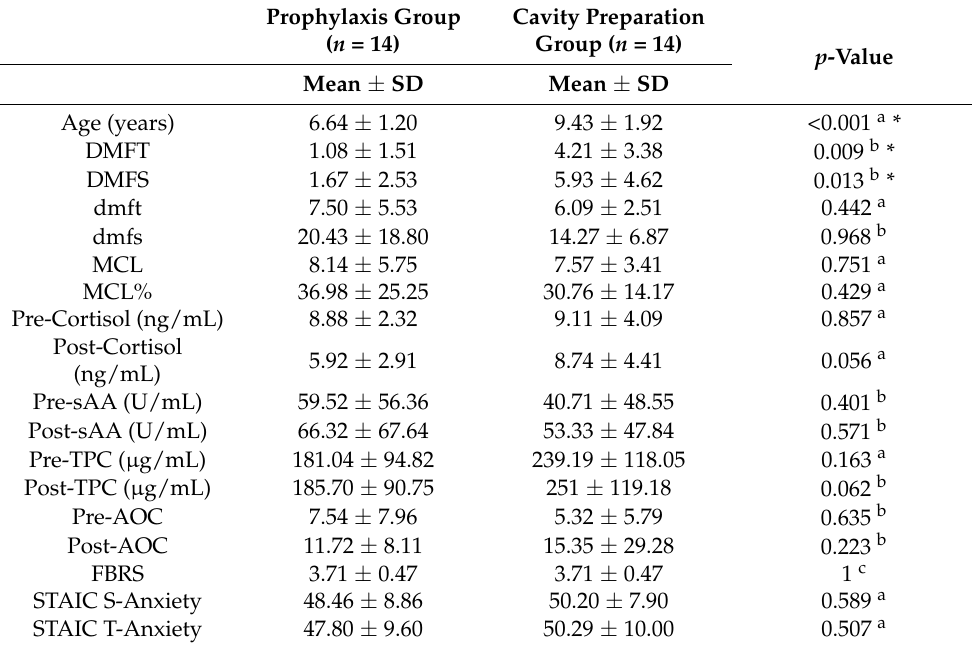
Table 4. Comparative evaluations for prophylaxis and cavity preparation